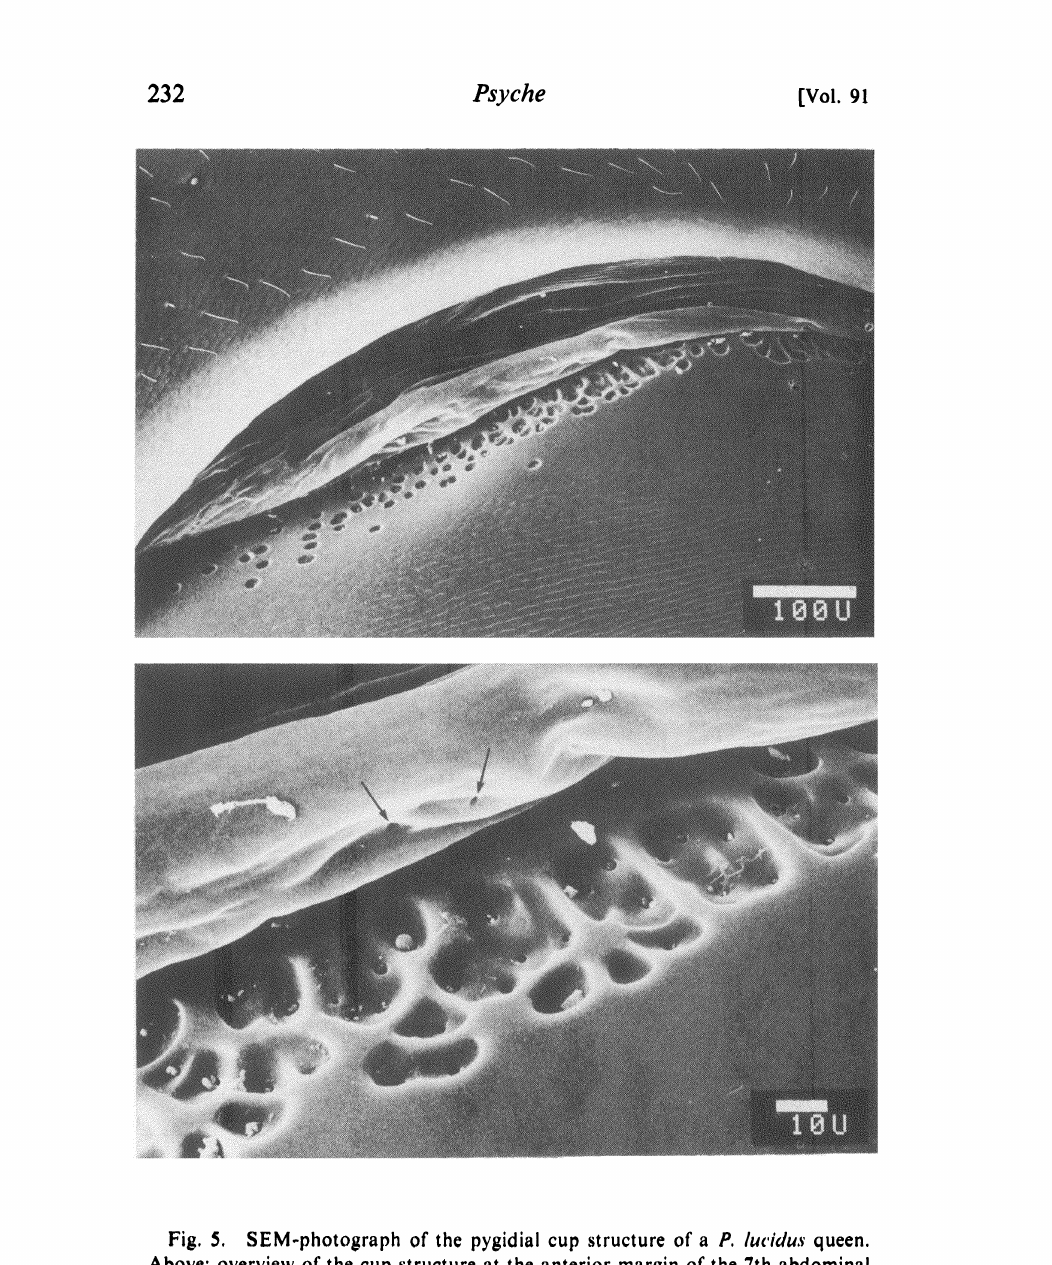
Fig. 5. SEM-photograph of the pygidial cup structure of a P, lucidus queen. Above: overview of the cup structure at the anterior margin of the 7th abdominal tergite. Below: close-up of the cup structure. Arrows point ot the intersegmental duct